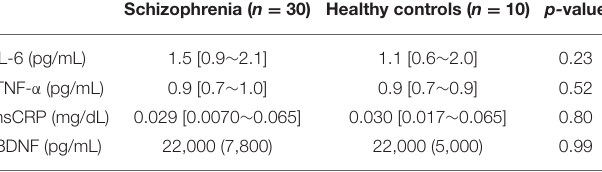
TABLE 3 | Serum levels of cytokines, hsCRP, and BDNF in the schizophrenia group and the healthy control. Schizophrenia ( n = 30) Healthy controls ( n = 10) p-